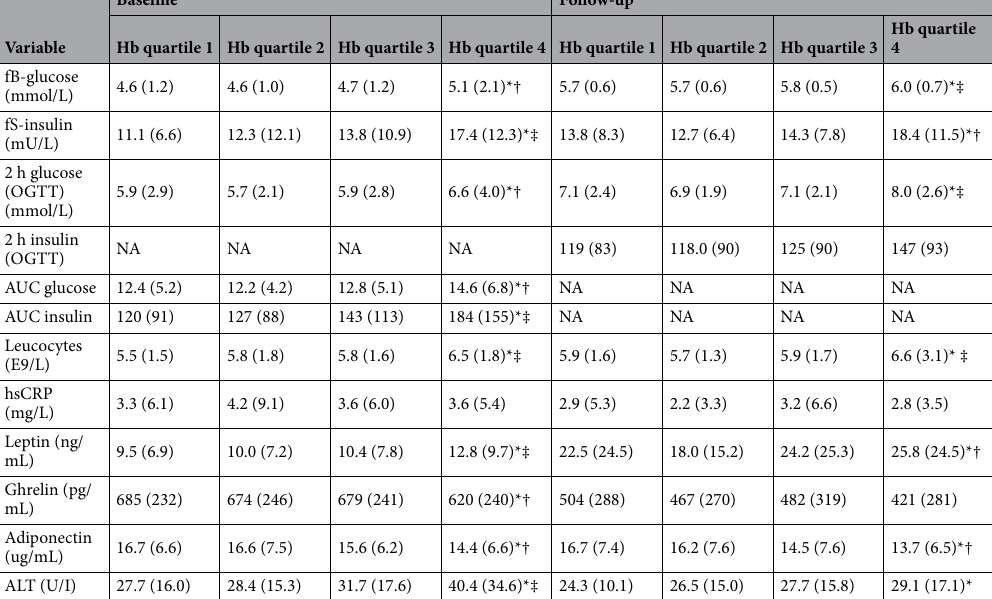
Table 1. Characteristics and CVD risk factors of the study-group in the Hb quartiles at baseline and at the follow-up. The values are mean with (SD) or percentages. SD Standard Deviation, Hb Hemoglobin, BMI Body